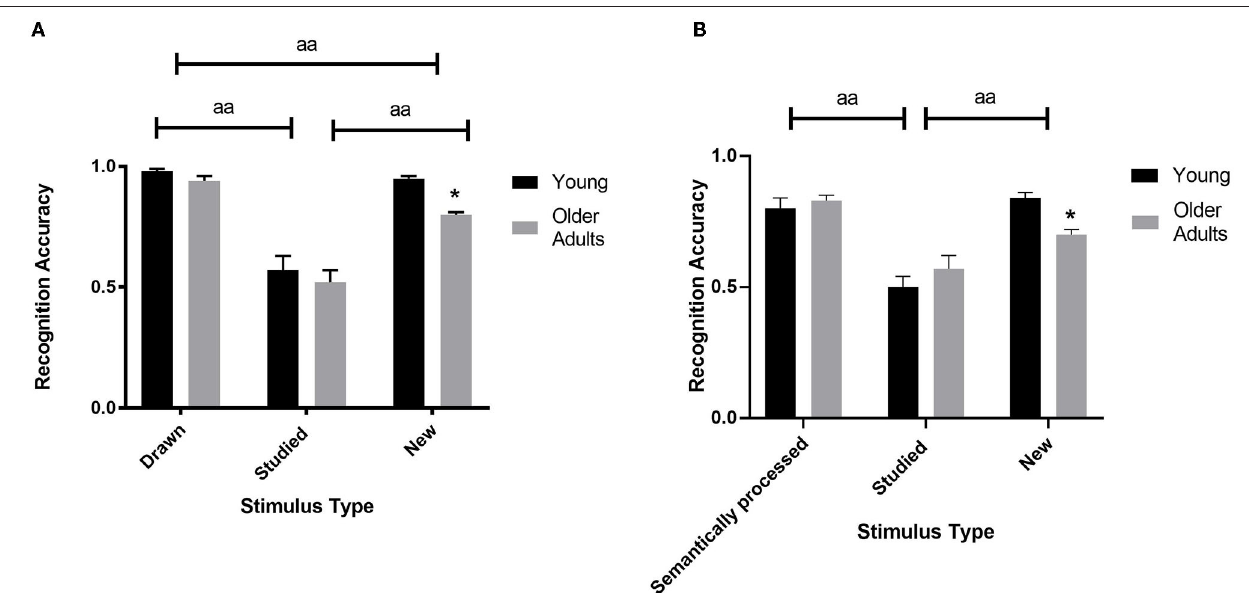
FIGURE 3 | Recognition accuracy performance of the abstract figures (A) and the non-words (B) according to age (young and older adults) for the hit rates of the drawn/semantically processed and studied items, and the correct rejection rates in repose to the new items. The bars represent the means. Age effects: *: p < 0.05. Stimulus type effects: aa: p <